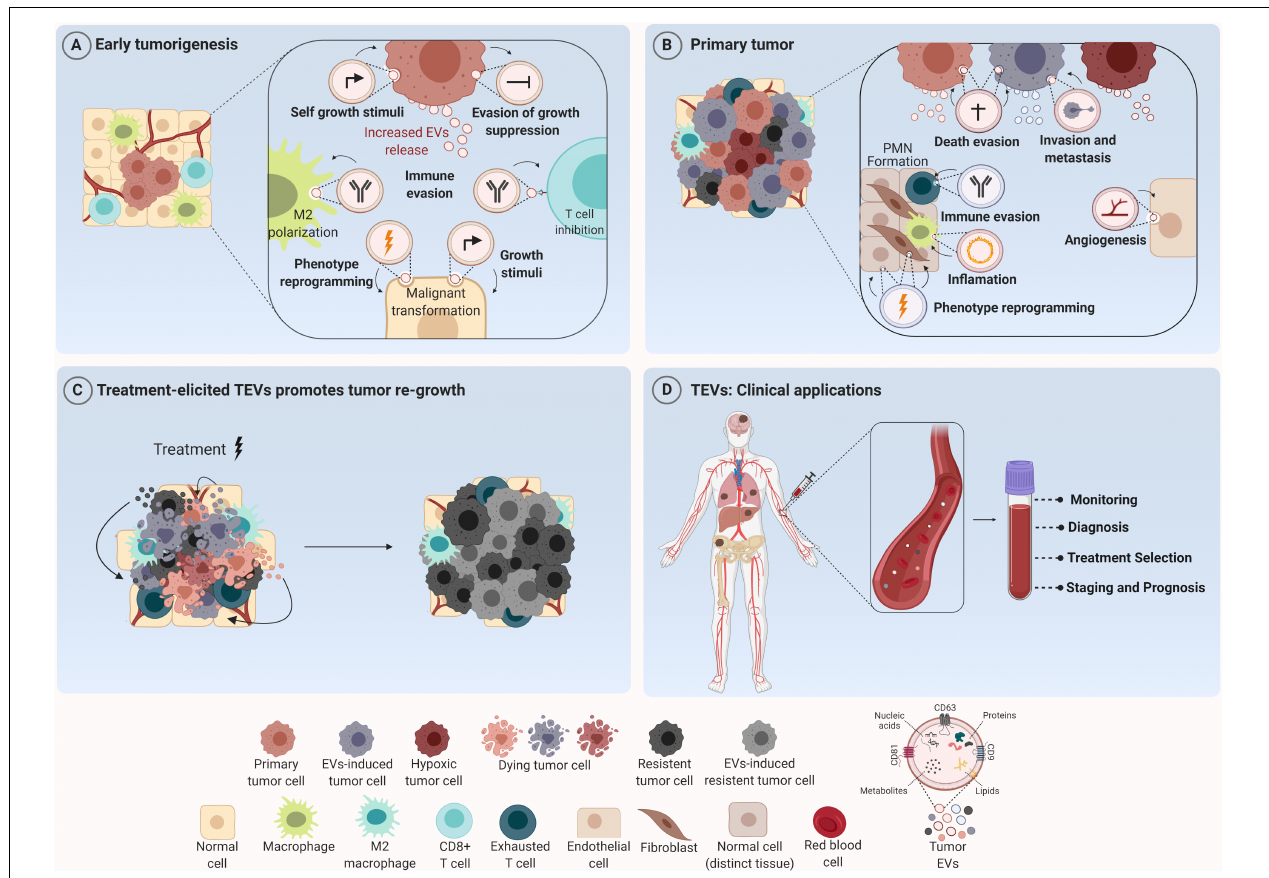
FIGURE 1 | Tumor-derived extracellular vesicles (TEVs) as mediators of tumor development and their use as potential theranostic biomarkers in oncology. (A) TEVs have been recognized as important modulators of many biological processes that govern tumor initiation such as sustained cell growth, evasion of antiproliferative and death stimuli, and immune evasion. Their uptake by tumor and stromal cells induces phenotype reprogramming that supports malignant transformation and tumor establishment. (B) Along tumor progression these nanostructures are able to create a permissive microenvironment characterized by sustained angiogenesis, inflammatory and immunosuppressive milieu at short and long distances supporting the formation of the pre-metastatic niche (PNM). (C) In addition, TEVs secreted in response to therapy can elicit a bystander effect in both tumor and stromal cells, inducing cell survival and outgrowth resulting in tumor recurrence. (D) In the clinical setting, since TEVs can reach all body fluids, they can be found in peripheral circulation and used for cancer diagnosis, prognosis and also as biomarkers for monitoring tumor response to therapies. Figure created using